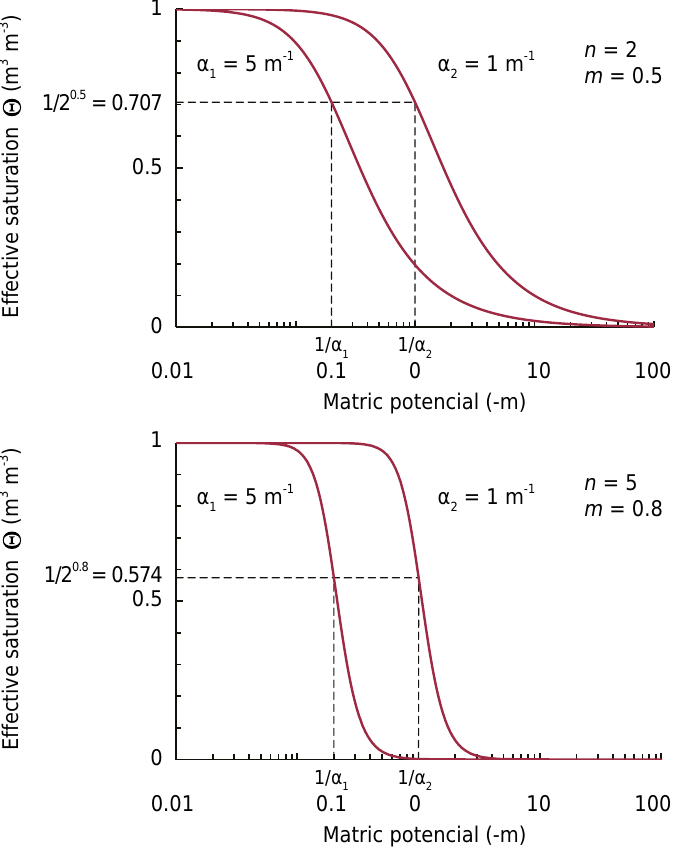
Figure3. Effective saturation Q as a function of the matric potential for two values of parameter a and n = 2 (top) and n = 5 (bottom). The lines 1/ a indicate the supposed values of the air-entry pressure according to equation 6, with corresponding Q b given by equation